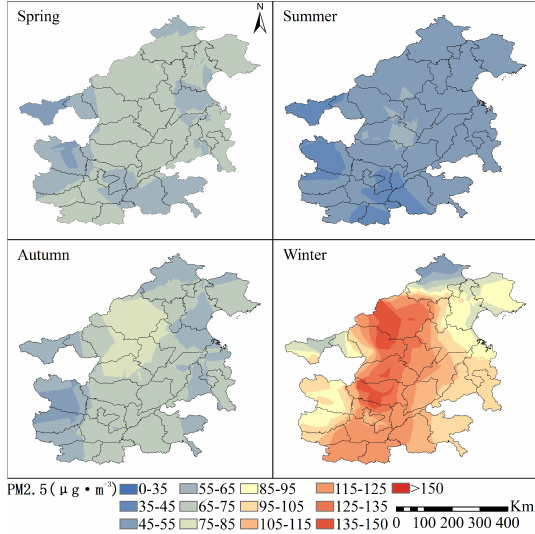
Figure 7. Spatial distribution of seasonal PM2.5 concentration in the “2+26”